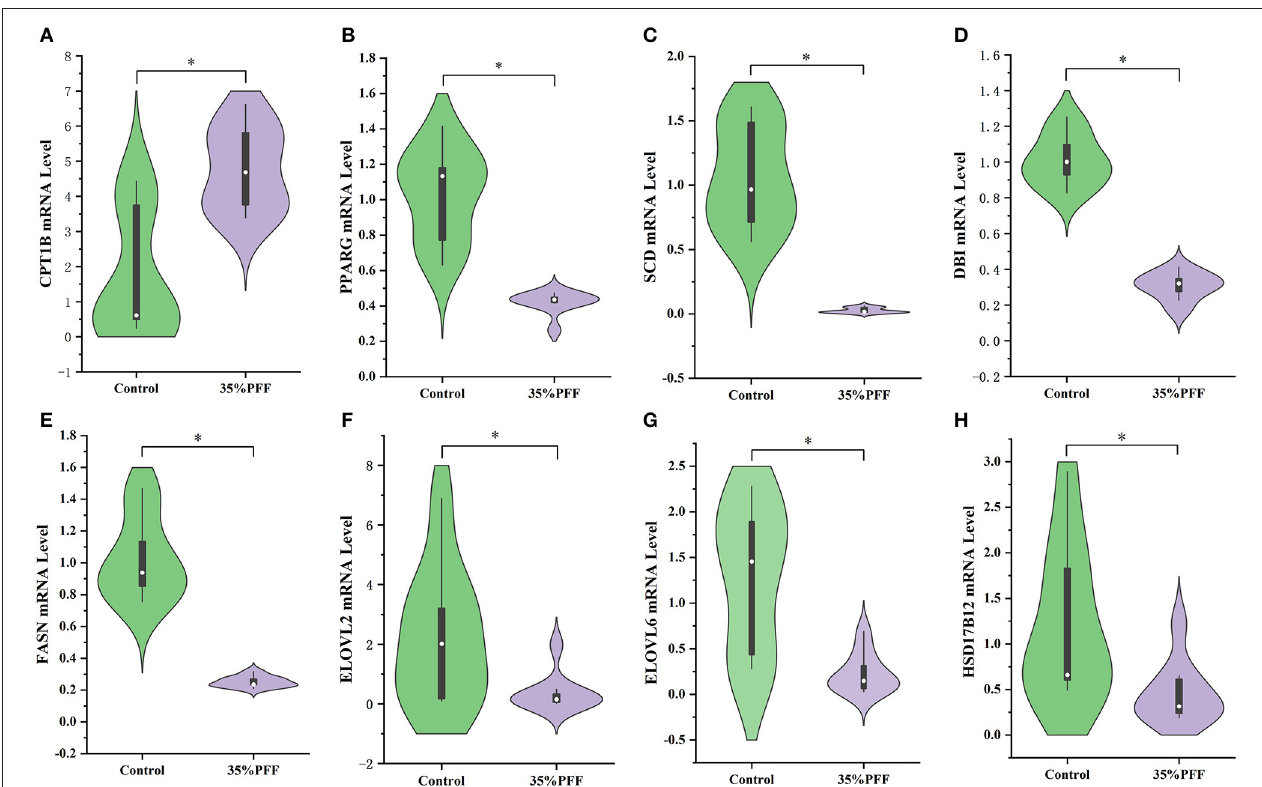
FIGURE 4 | Results from quantitative real-time PCR (qRT-PCR) validation. (A) CPT1B. (B) PPARG. (C) SCD. (D) DBI. (E) FASN. (F) ELOVL2. (G) ELOVL6. (H) HSD17B12. Significant expression difference between control group (denoted in green color) and 35% PFF group (denoted in purple color) verified by qRT-PCR of eight genes. * p <